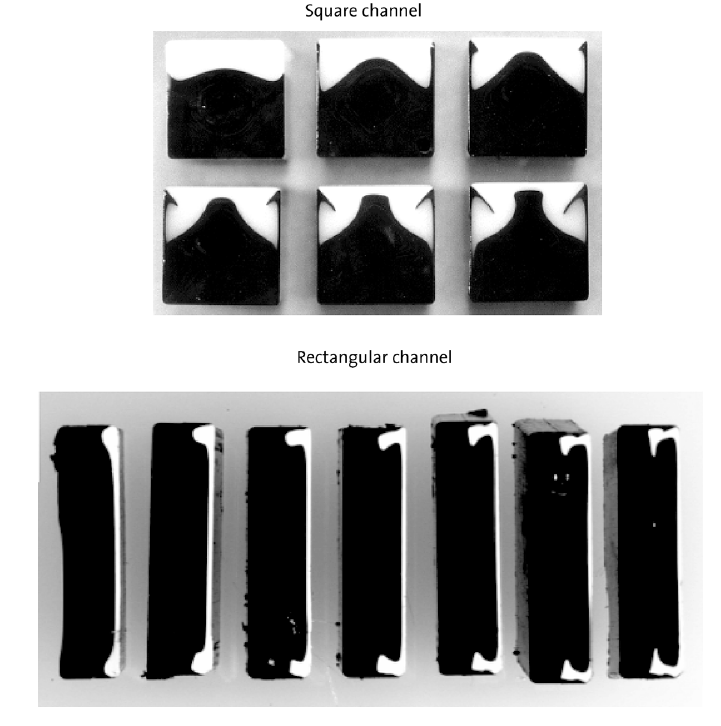
Figure 1 (left): Secondary flow in the axial cross section of the slit. Figure 2: Experimental results show- ing the evolution of materi- al in a square and rectangu- lar